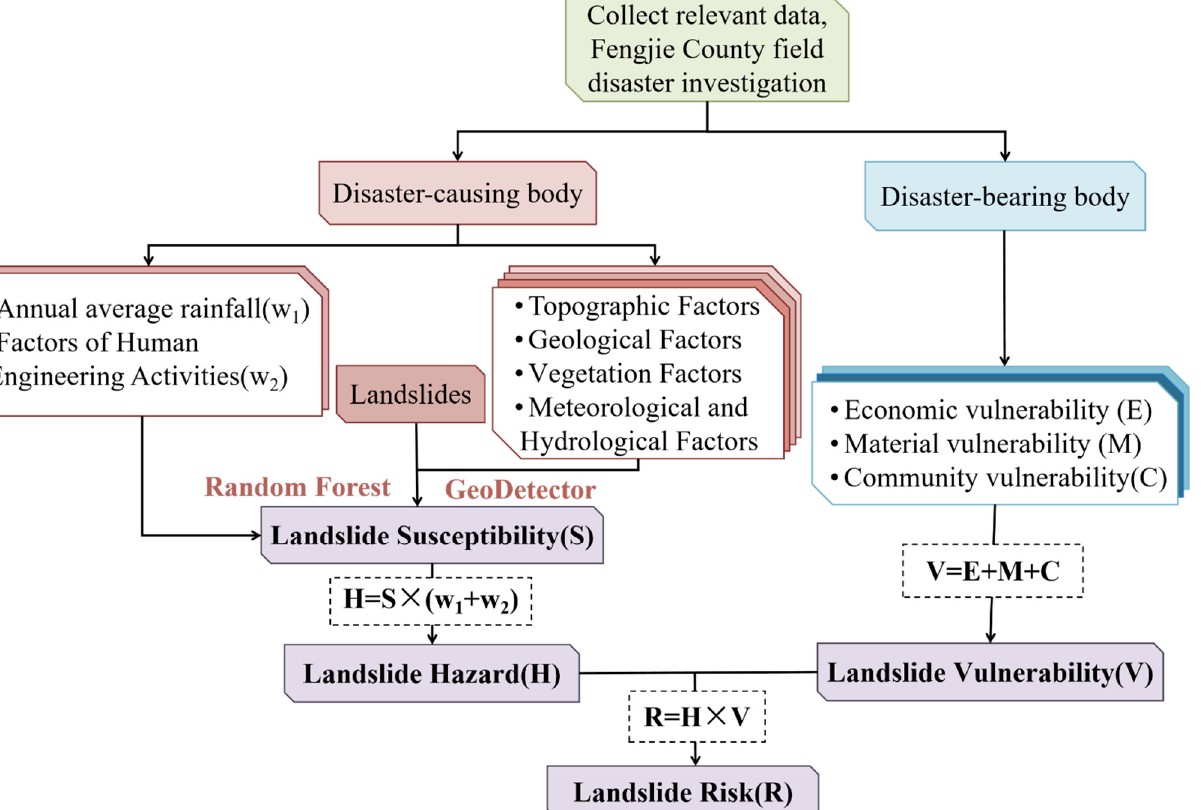
Figure 8. The methodological framework of the study.